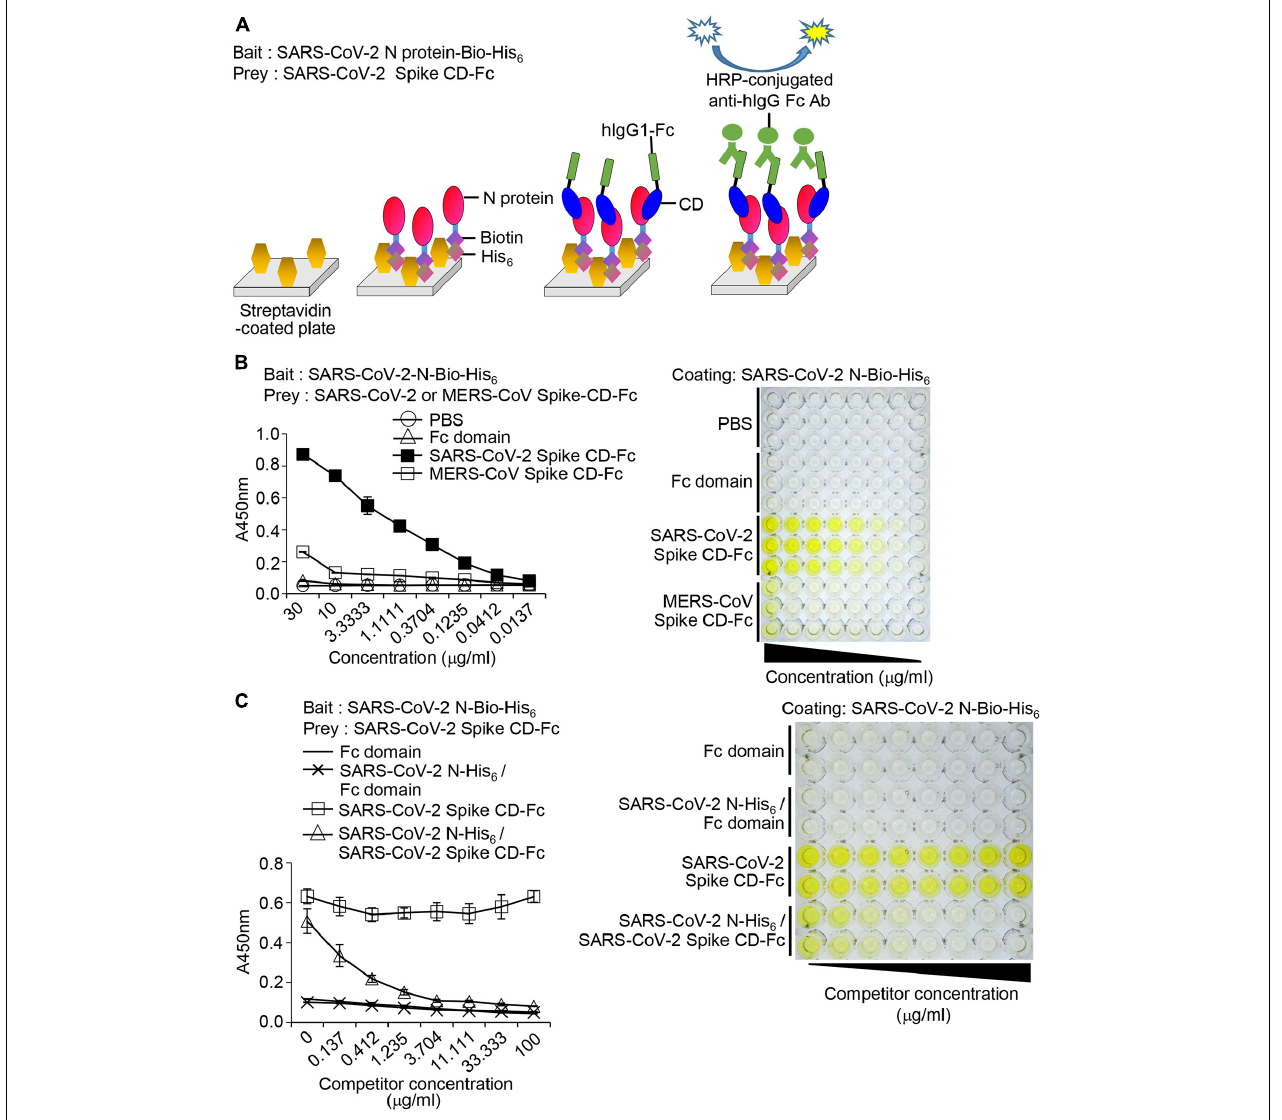
FIGURE 6 | Interaction between SARS-CoV-2 Spike CD-Fc and SARS-CoV-2 N-Bio-His 6 recombinant proteins. (A) Schematic of the bait and prey assay system. (B) Immunoplates (96-well) were coated with streptavidin and then recombinant SARS-CoV-2 N-Bio-His 6 protein was added to each well. After addition of MERS-CoV Spike CD-Fc or SARS-CoV-2 Spike CD-Fc, the amount of CoV Spike CD-human Fc fusion protein bound to recombinant SARS-CoV-2 N-Bio-His 6 protein in the wells was determined by ELISA. (C) Specificity of the interaction between SARS-CoV-2 Spike CD-Fc and SARS-CoV-2 N-Bio-His 6 recombinant protein. Serially diluted non-biotinylated-recombinant SARS-CoV-2 N-His 6 protein was incubated with SARS-CoV-2 Spike CD-Fc and then added to the wells containing SARS-CoV-2 N-Bio-His 6 -coated streptavidin. The extent of the competition was measured by ELISA using HRP-conjugated anti-human IgG Fc antibody.